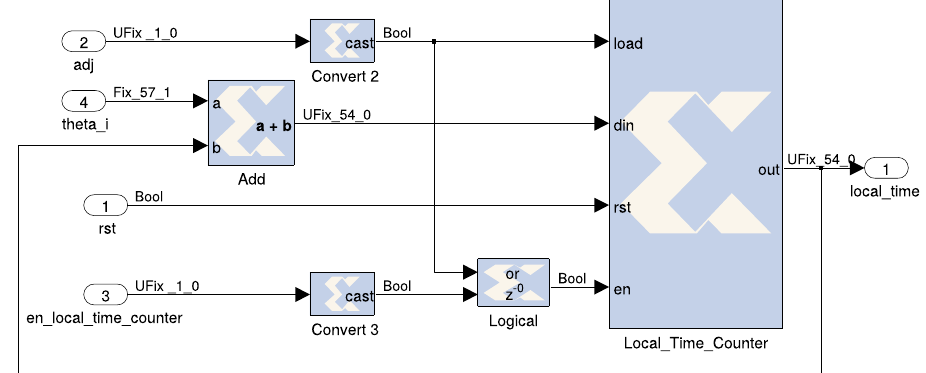
Figure 10. Local clock implementation details using the system generator for DSP